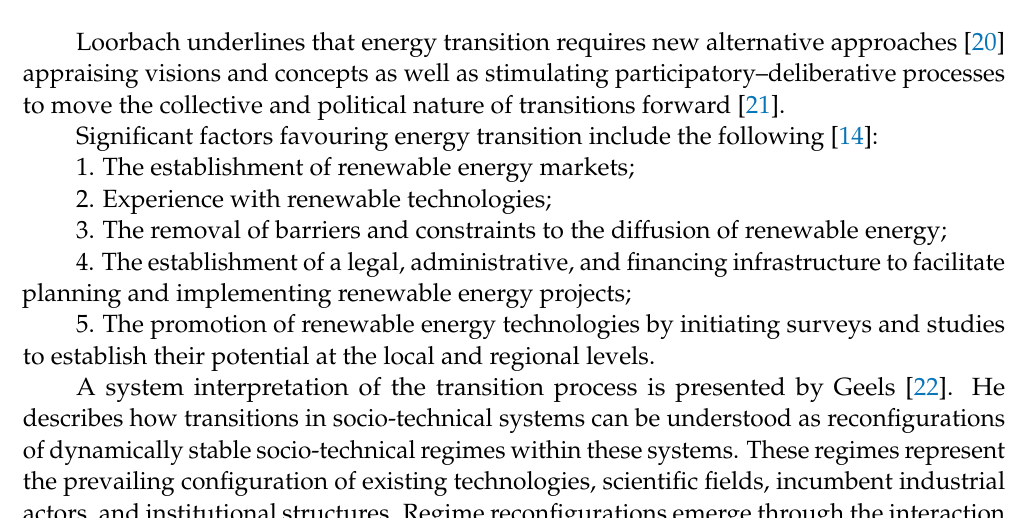
Figure 2. The key elements of transition from brown to green economy. Source: own study based on [19].